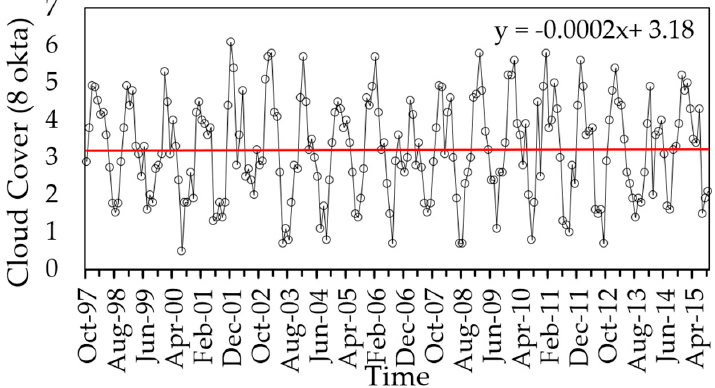
Figure 8. Time series and linear trend analyses of pan evaporation data between 1997 and 2015.